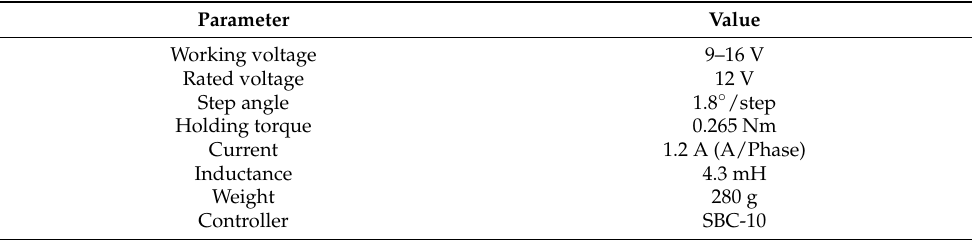
Table 3. Basic parameters of the stepping